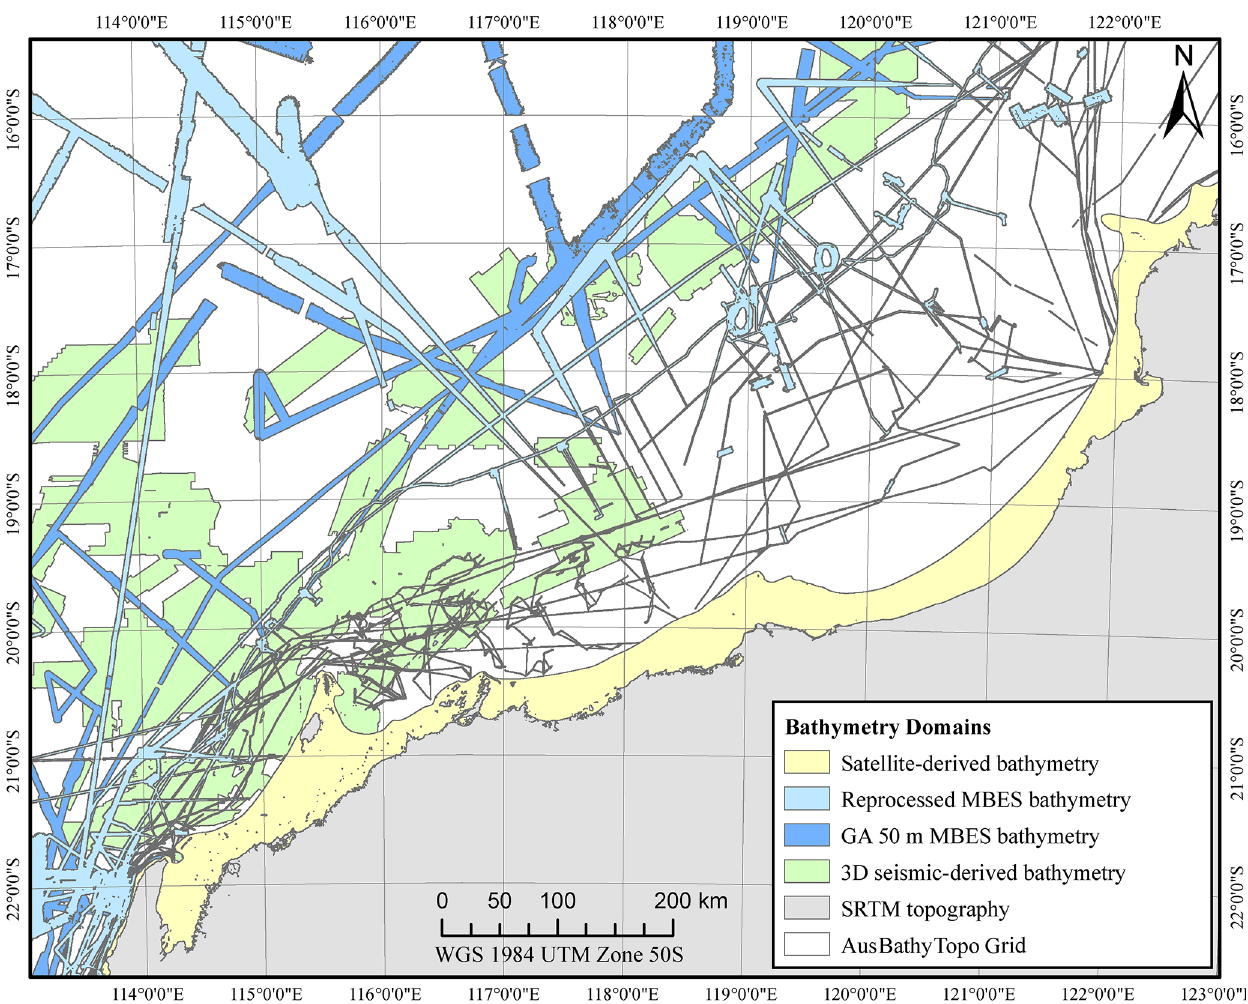
Figure 13. Lineage of the datasets included in the regional bathymetry compilation. For data sources, see Sects. 3, 4.2.1, 4.3.1, and